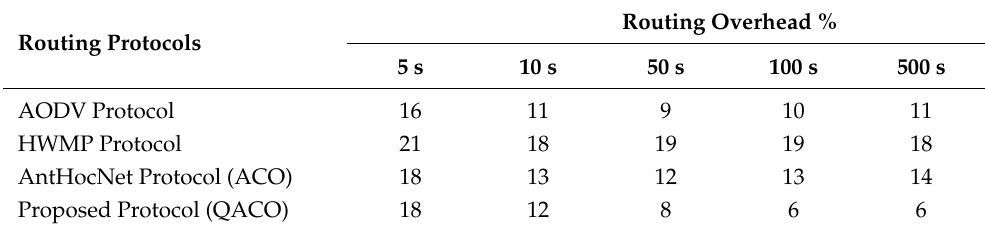
Table 6. Simulation running time-variant routing overhead.